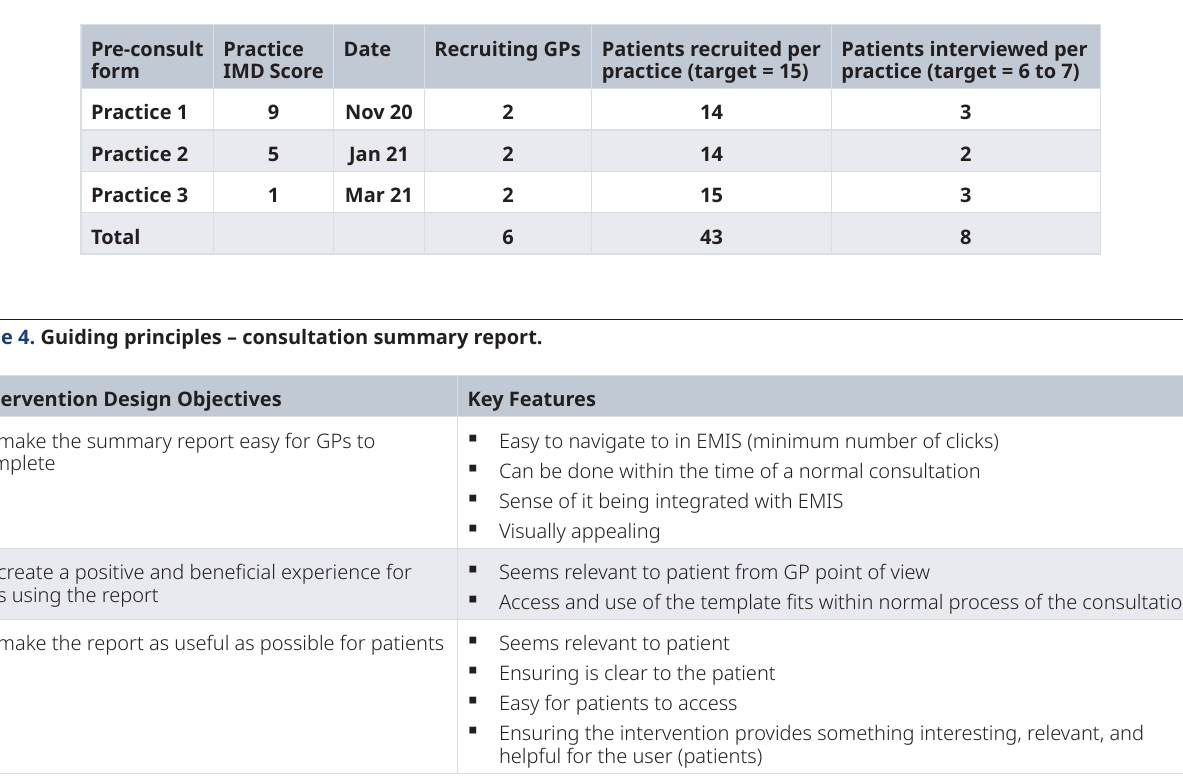
Table 3. Development of the pre-consultation form: GP and patient recruits.